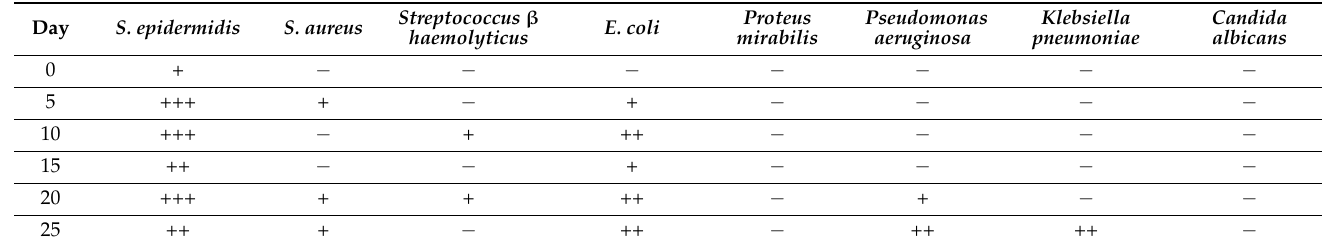
Table 1. Identification of healthy skin pathogens in pig I.